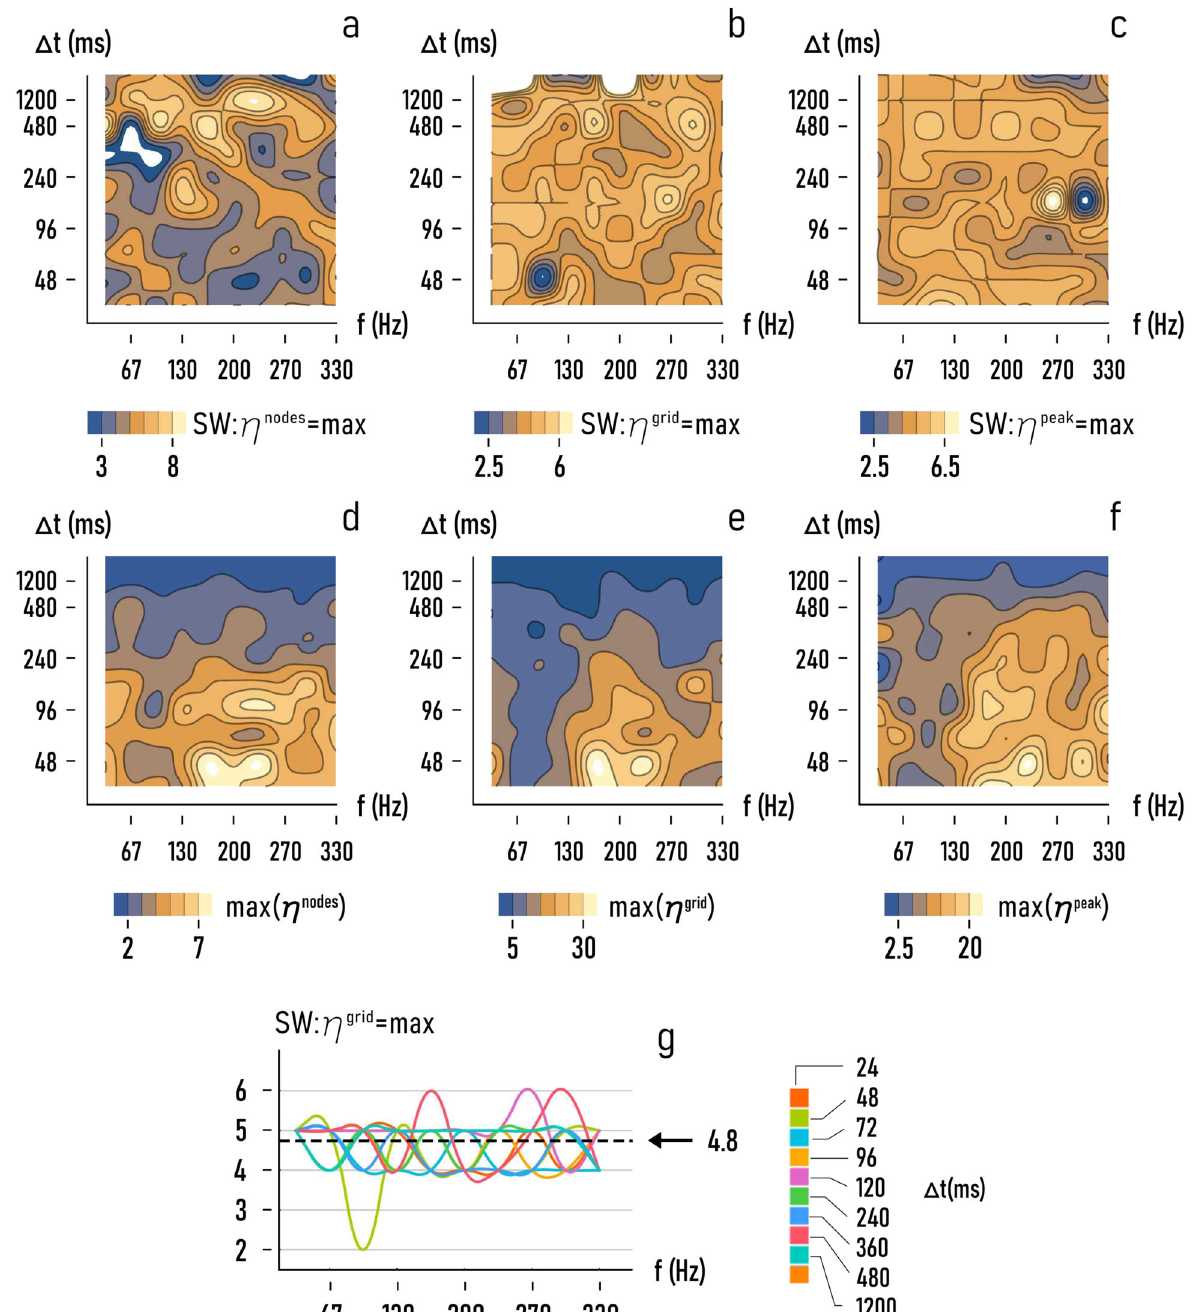
Fig. 5 Optimal small-world-ness of the networks. For different combinations of f and 4 t , we determined the optimal values of small-world- ness SW for which η nodes ( a ), η grid ( b ) and η peak ( c ) are maximum in the networks, and the corresponding maxima ( d – f ). For the particular case of η grid , we observe that optimal small-world-ness assuring the maximum ef fi ciency in the grid oscillates around the mean value SW ¼ 4 : 8±1 ( g ). The white regions in the diagrams indicate values that are out-of-range, i.e., values of the functions that fl uctuate either below or above the minimum (maximum) of the plot range identi fi ed through the color legend bar that accompany each diagram. These areas are ascribable to interpolation errors in the graphical representation of the values as smooth functions of the variables and do not affect to any extent the fi ndings and conclusions of the